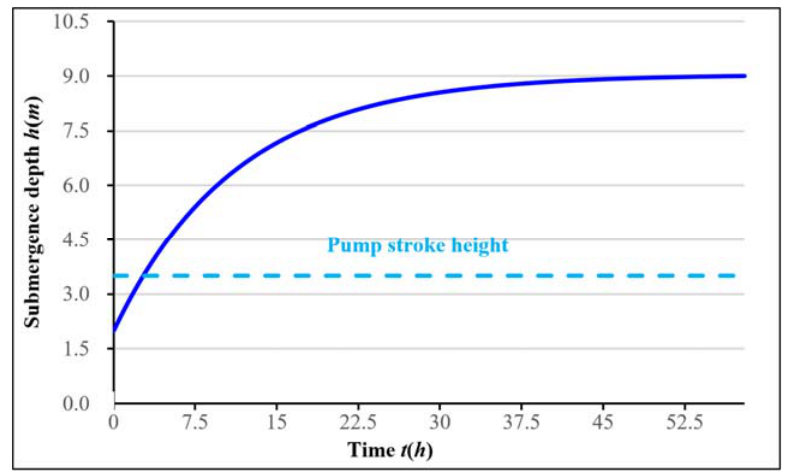
Figure 5. Schematic diagram of transition from the nonfull-pumping state to the full-pumping state. Regarding the parameters h E and C f of the oil well model in the full-pumping state (Formula (5)), when the oil well transitions into the nonfull-pumping state, the current submergence depth satisfies h < h p ; the parameters h E and C f do not change, and at this time, the initial submergence depth h 0 is replaced by h p . The state model Formula (5) is replaced by Formula (8), and the time restarts. The transition of an oil well from the nonfull-pumping state to the full-pumping state is similar to the transition process described